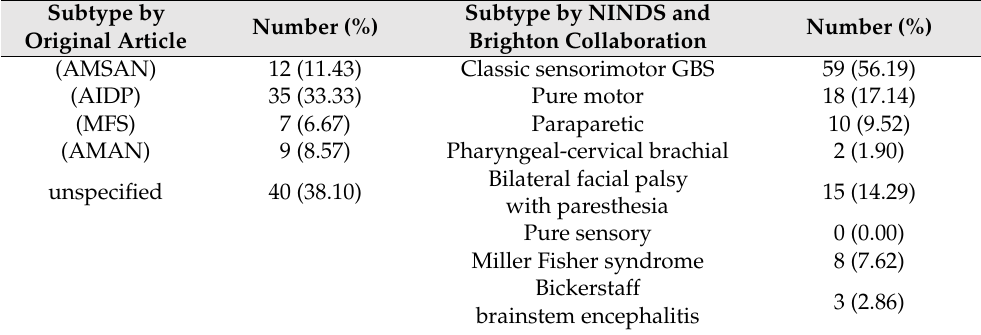
Table 1. Subtypes of